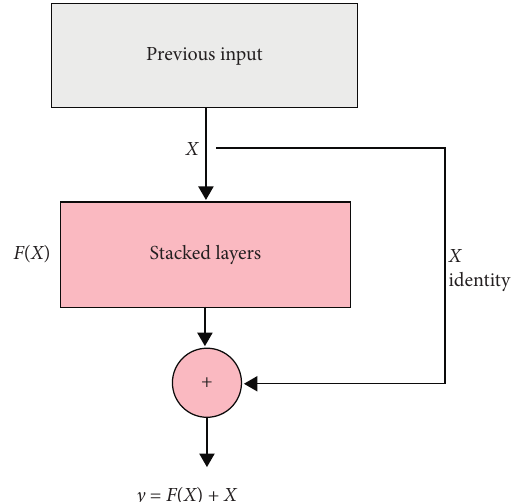
Figure 2: The diagram of residual connection. Table 1: The detailed information about ResNet-50.